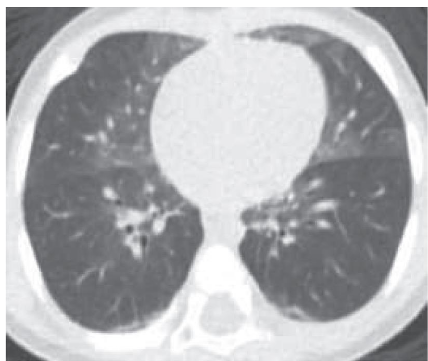
Figure 1: CT chest axial view shows groundglass opacities pri- marily involving right middle lobe and lingula.